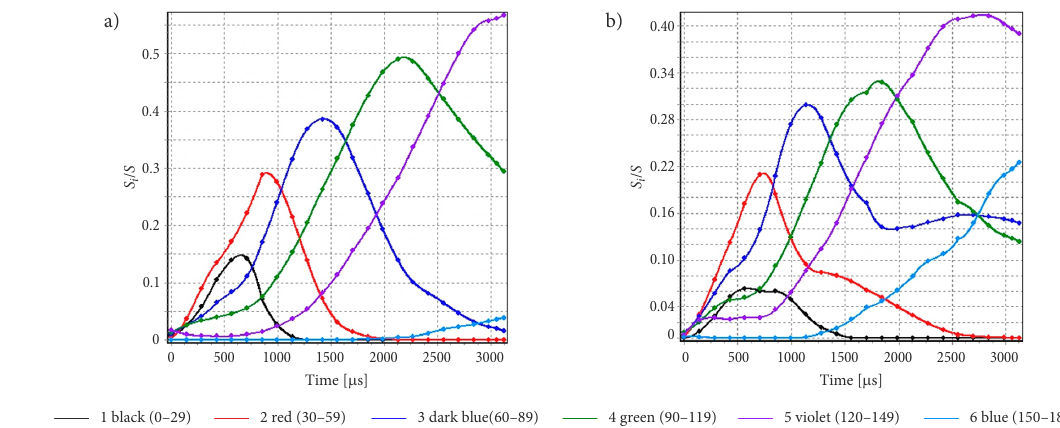
Figure 5. The structure of the fuel jet in CR system: a – DF; b – RME